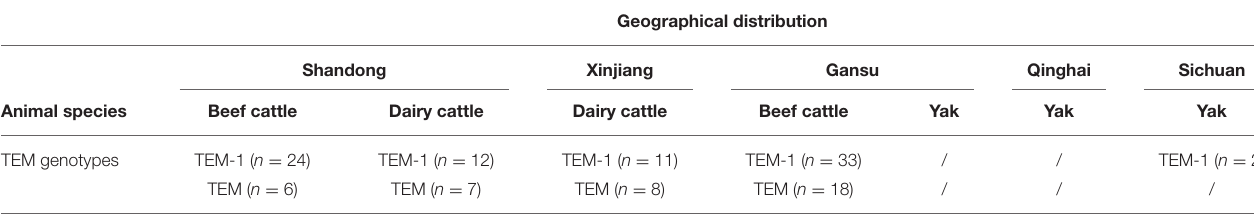
TABLE 4 | The distribution of TEM genotypes in different bovines and sampling